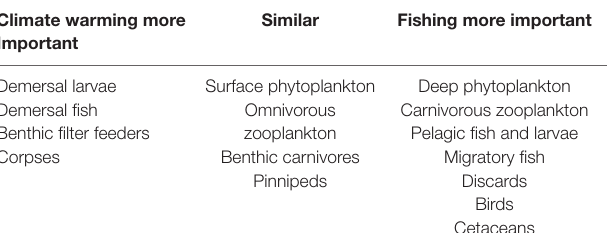
TABLE 2 | The relative importance of fishing and climate across scenarios for the StrathE2E2 functional